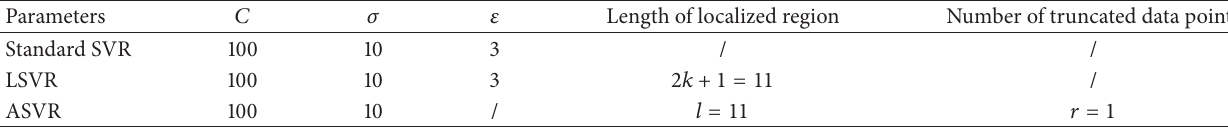
Table 1: Parameters setup for standard SVR, LSVR, and ASVR.